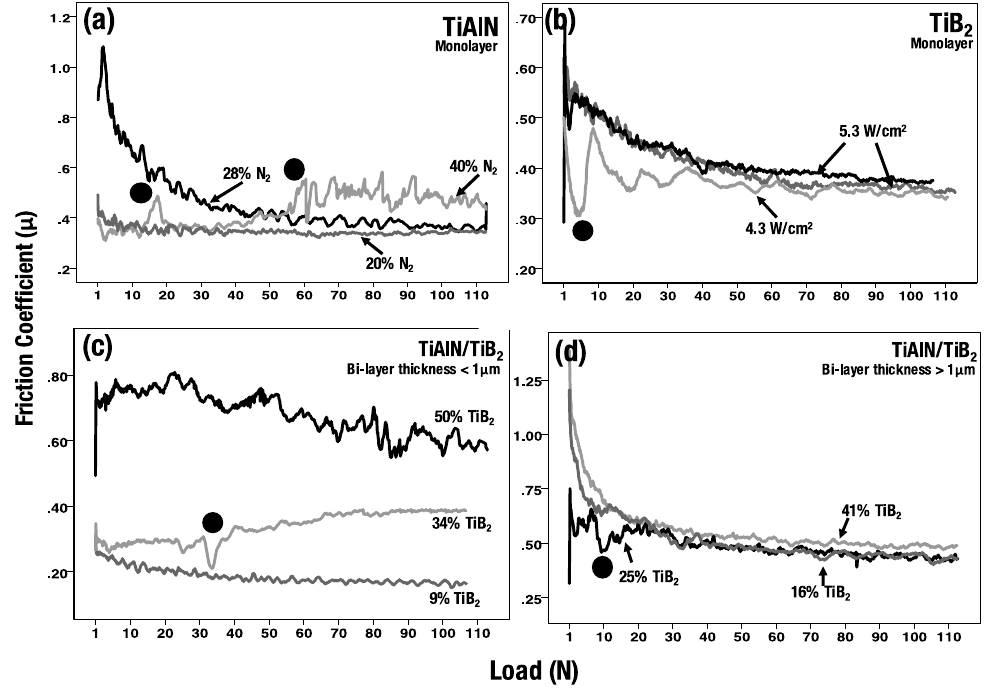
Figure 2. Tribological investigations of ( a ) monolayer TiAlN deposited in different partial pressures of nitrogen, and ( b ) monolayer TiB 2 deposited with different power densities. Graphs ( c , d ) show the contrast in characteristics between the two sets of bilayer thicknesses, with coatings fabricated with a bilayer thickness of >1 μ m showing frictional coefficients of around 0.5 with little or no variability between the compositions in contrast to those where the bilayer thickness is of <1 μ m.